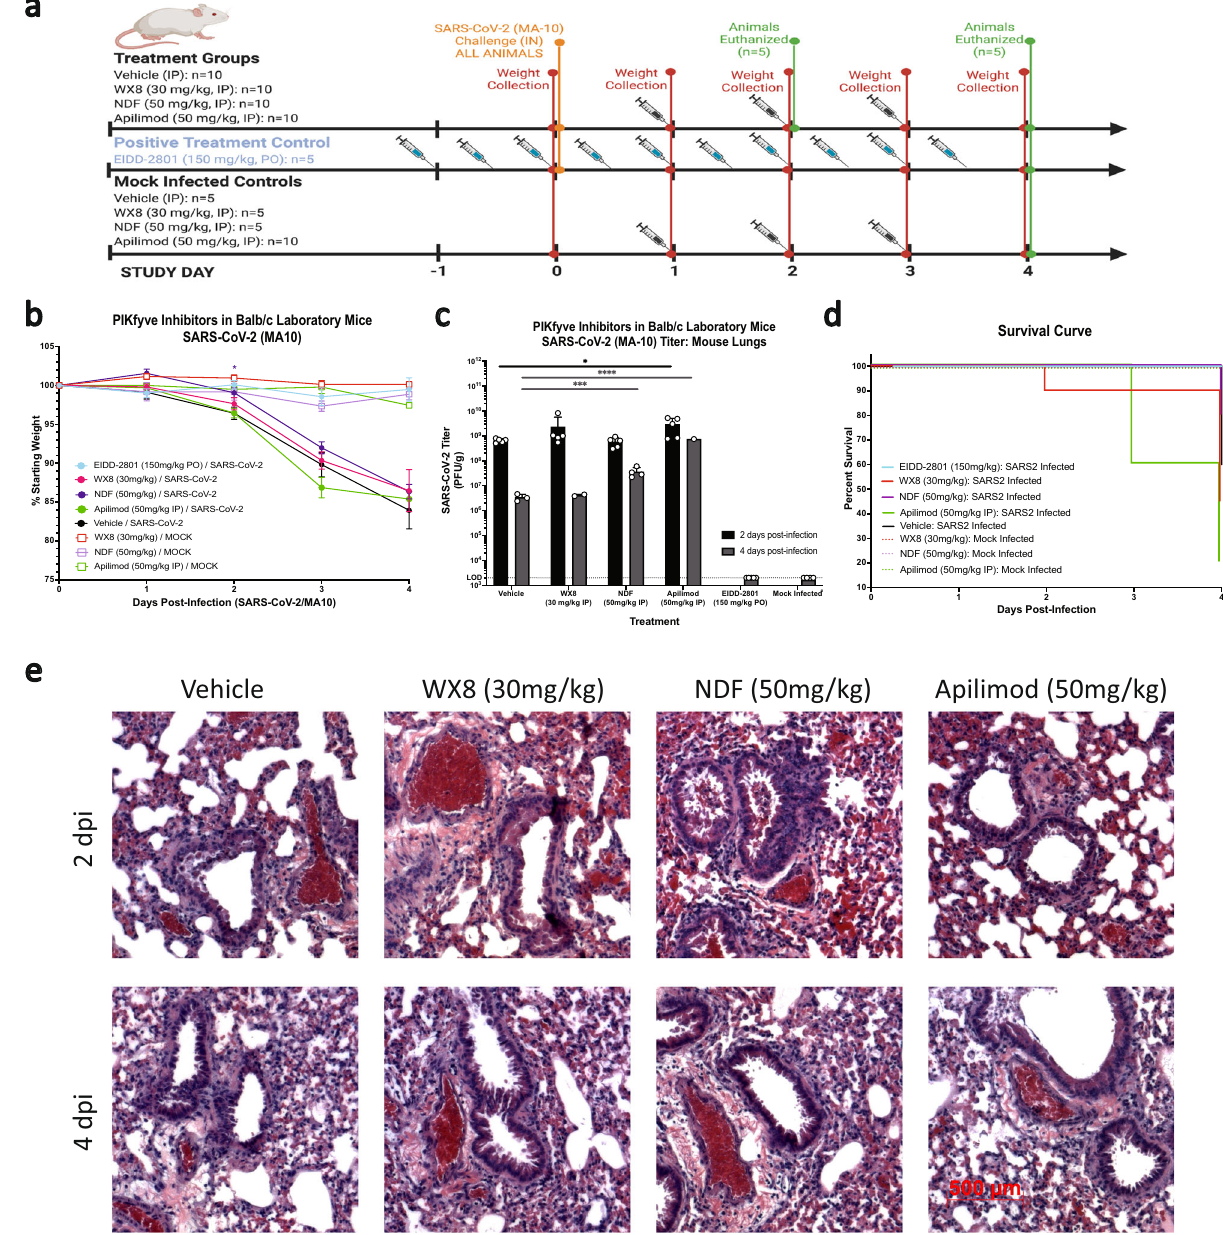
Fig. 3 Post-exposure treatment ef fi cacy of PIKfyve inhibitor treatment against SARS-CoV-2 infection in mice. a Groups of mice were treated intraperitoneally with PIKfyve inhibitors Apilimod, WX8, or NDF once daily beginning 1 day post-intranasal-challenge with 1 × 10 3 plaque forming units SARS-CoV-2 (MA-10). EIDD-2801 dosed twice a day was used as a positive treatment control and uninfected treatment controls were included to assess cytotoxicity. Image created using Biorender. b Weight changes were determined for 4 days post-challenge, plotted as the group mean with error bars indicating the ±SD. c Infectious viral loads from lung homogenates at 2- (black) or 4- (gray) days post SARS-CoV-2 challenge. d Survival curves for treatment groups. e Lungs were collected at 2- or 4-days post-challenge and stained with hematoxylin and eosin to assess bronchiolar and alveolar damage and immune cell in fi ltration (500- μ m scale bar shown at bottom left, representative for all panels). Mixed-effects analysis was used to compare differences in weight change or viral loads from lung homogenates between infection treatment groups and the vehicle-treated control group; * p ≤ 0.1, *** p ≤ 0.001, **** p ≤ 0.0001. dpi, days post-infection; PO, oral dosing; IP, intraperitoneal; IN, genes in SARS-CoV-2-infected lungs with treatment of either expression was signi fi cantly different in antigen-presenting cells, drug: NDF vs. untreated, granulocyte cluster ( z = − 2.2, showing a down-regulation of TLR9 and an upregulation of both p = 7.7 × 10 − 5 ); WX8 vs. untreated, granulocyte cluster TLR4 and TLR5 (Fig. 4e, shown for WX8). In addition to these ( z = − 2.6, p = 8.1 × 10 − 7 ); NDF vs. untreated, APC cluster single-cell sequencing results, we also found that WX8, NDF, and ( z = − 1.0, p = 3.9 × 10 − 2 ); WX8 vs. untreated, APC cluster Apilimod modulate secretion of proin fl ammatory cytokines in response to infection by another human coronavirus, hCoV- ( z = − 3.0, p = 2.3 × 10 − 6 ). Negative z-scores indicate predicted pathway inhibition 26 . In addition, Toll-like receptor (TLR) OC43, in studies with cultured HUVECs. Treatment with WX8,